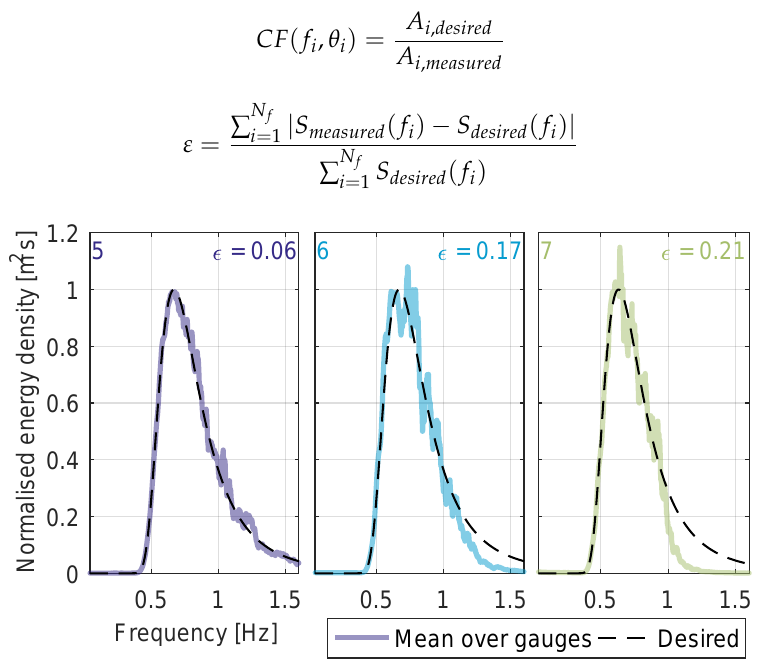
Figure 5. Corrected mean wave spectra compared to the desired. Correlated (from left to right) with Sea States 5–7 defined in Table 3. Error values, as calculated from Equation (19), shown in the top